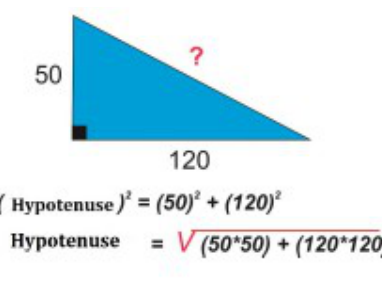
Figure 6. Remediaton for queston 5: a) used afer 1st unsuccessful